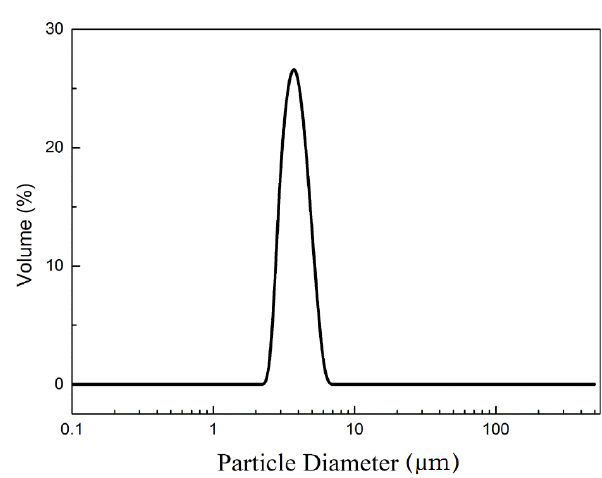
Figure 5: Particle size distribution of